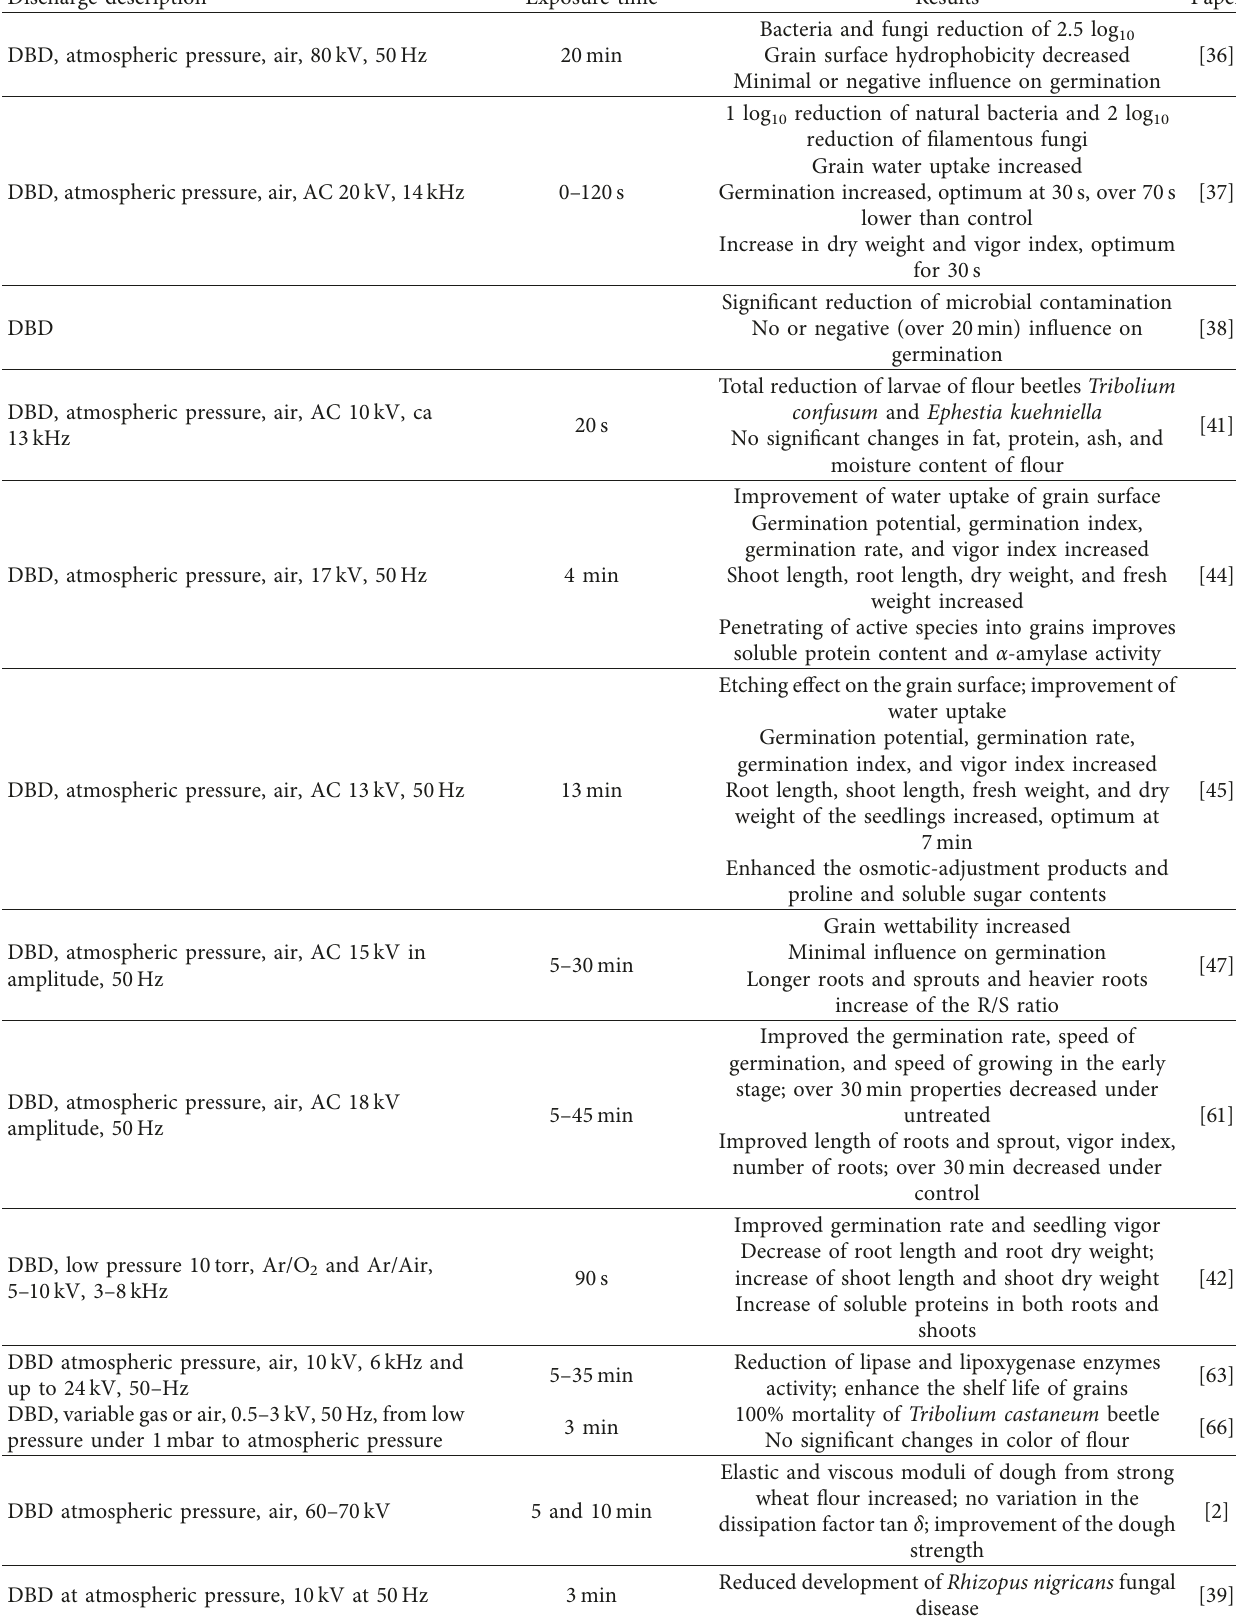
Table 1: Experimental conditions and results of some attempts to influence wheat grains and flour